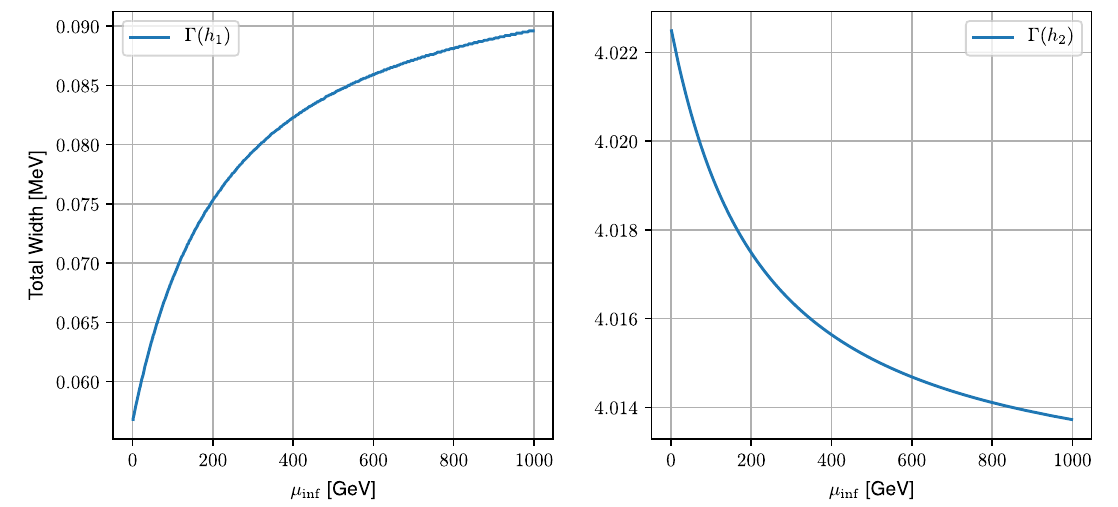
Fig. 9 The total widths of the lightest scalar Higgs h 1 and second lightest Higgs h 2 depending on the pure μ inf effect Fig. 10 The lightest scalar Higgs production cross section at 250 GeV ILC depending on the pure μ inf